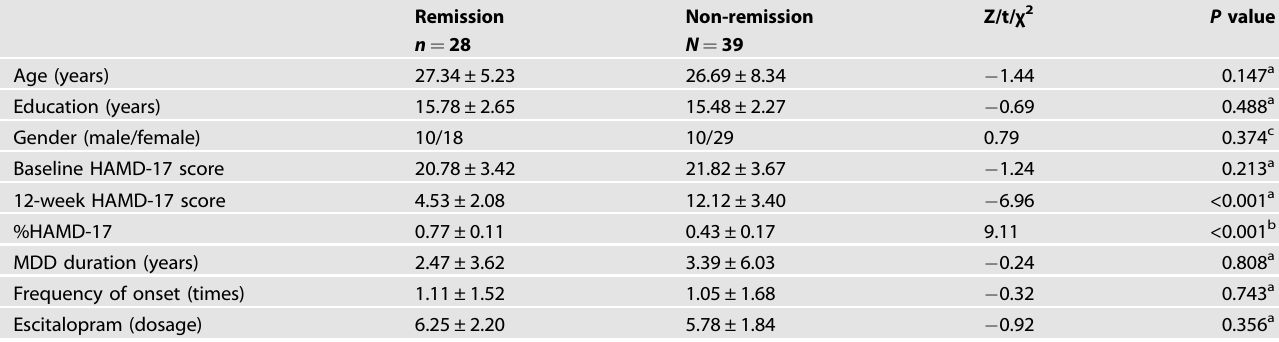
Table 1. Demographic and clinical characteristics of MDD patients.